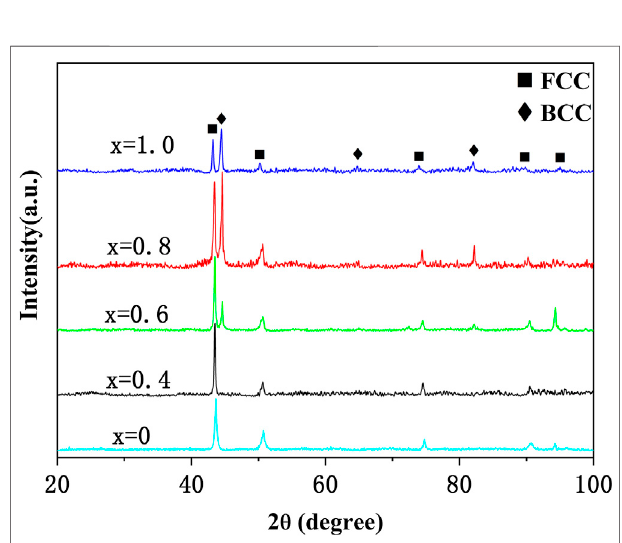
FIGURE3| XRDpatternsofsinteredbulkyFeCoNi(CuAl) x MEAandHEAs.